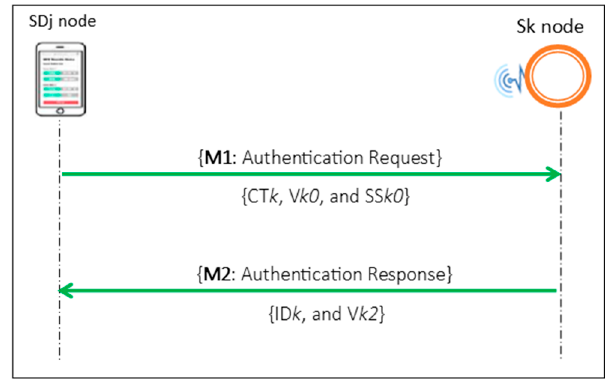
Figure 4. WMSN authentication phase (WAP).